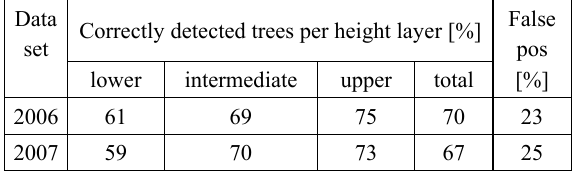
Table 5. 3D Detection of single trees in the reference